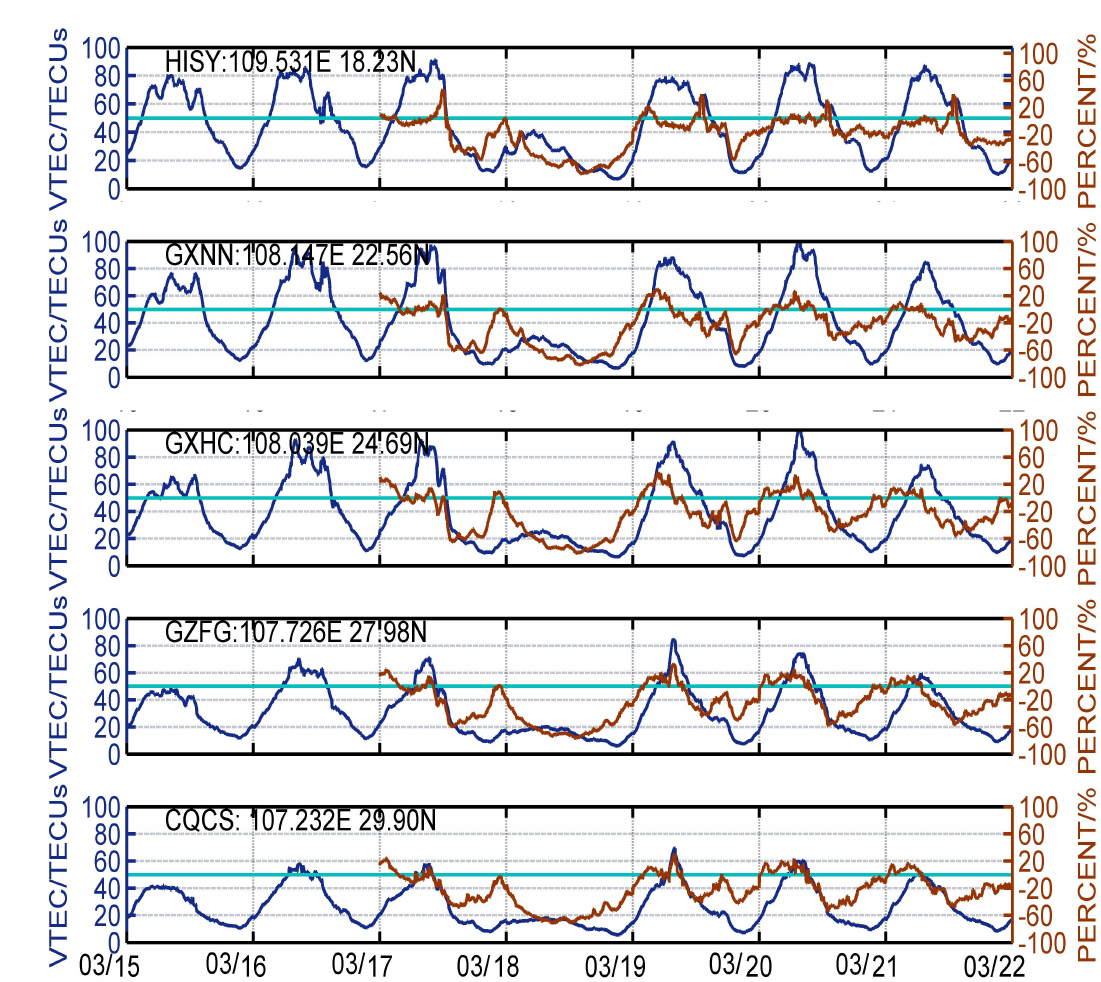
Figure 5. Variations of the VTEC and PERCENT at the low latitude stations of